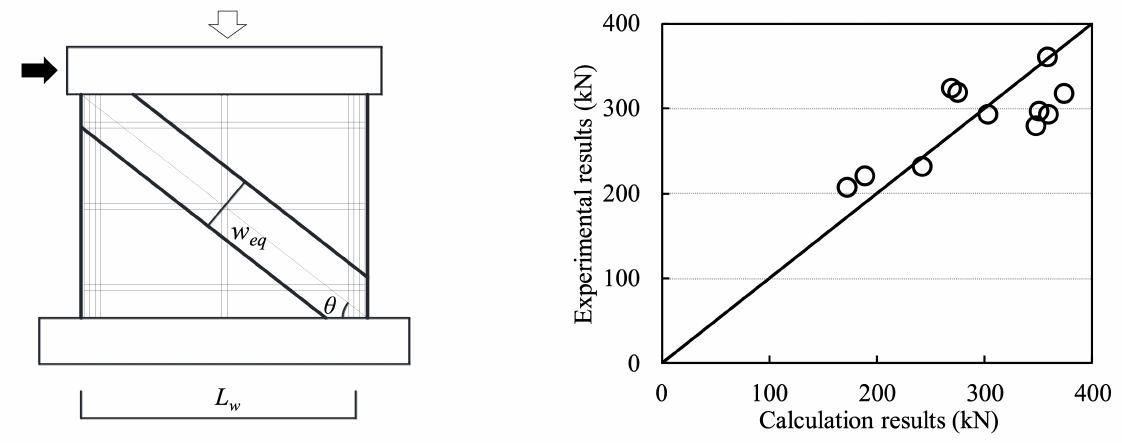
Figure 13. Concept and calculation results of diagonal strut mechanism.